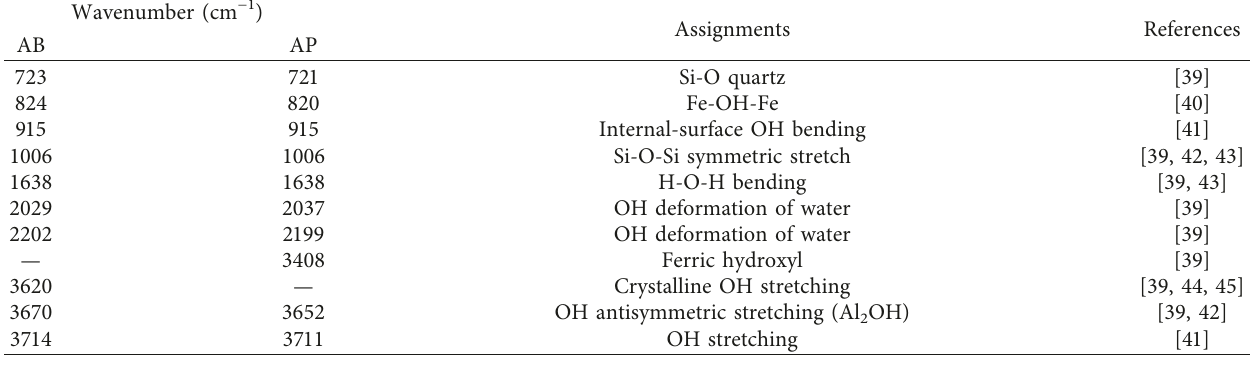
Table 2: FTIR spectra bands of raw (AB) and purified (AP) used